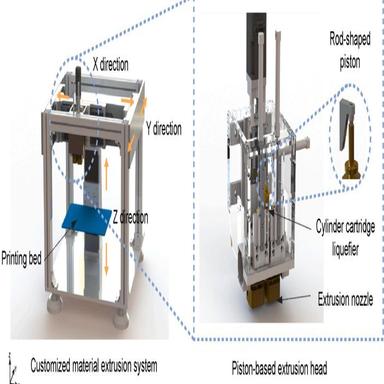
Customized piston-based material extrusion system that was used for 3D printing of the binder-coated zirconia feedstock.